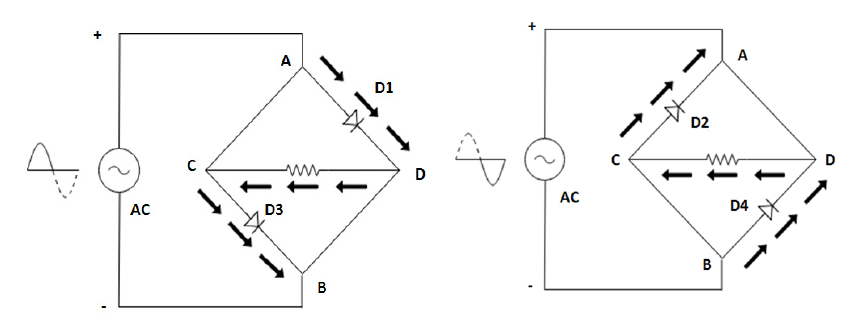
Figure 17. Schematic diagram of the Bridge Rectifier.